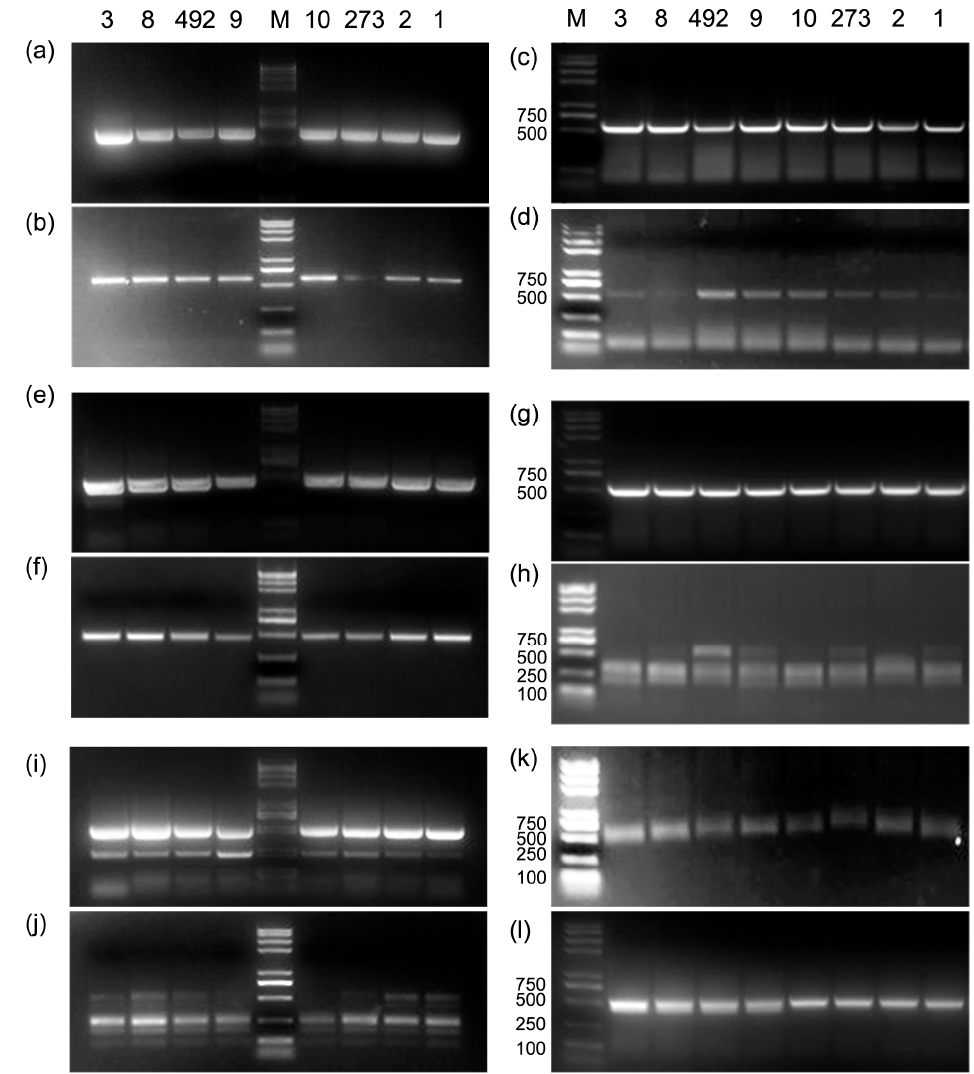
Figure 3. Test of CAPS markers in eight sweet potato germplasms. The numbers 3, 8, 492, 9, 10, 273, 2, and 1 represent the sweet potato germplasms shown in Supplementary Materials Table S1, which were Shangqiu52-7, Yushu33, Yanshu No.5, Chaoshu No.1, Xinxiang, Xiaohuaye, Mianfen No.1, and Suyu No.1, respectively. The measured starch contents of the eight germplasms were 4.476%, 25.611%, 11.036%, 10.206%, 19.584%, 14.728%, 29.386%, and 16.853%, respectively. The measured amylose–amylopectin ratio of the eight germplasms was 0.300, 0.308, 0.277, 0.309, 0.290, 0.282, 0.315, and 0.282, respectively. ( a ), ( c ), ( e ), ( g ), ( i ), and ( k ), PCR products obtained using CAPS1, CAPS5, CAPS6, CAPS3, CAPS2, and CAPS4 primers, respectively. ( b ), ( d ), ( f ), ( h ), ( j ) and ( l ), PCR products were digested using the corresponding restriction endonucleases. M, marker (Trans2K Plus II DNA marker, TransGen Biotech), the band size from top to bottom is 8,000; 5,000; 3,000; 2,000; 1,000; 750; 500; 250; and 100 bp, respectively.